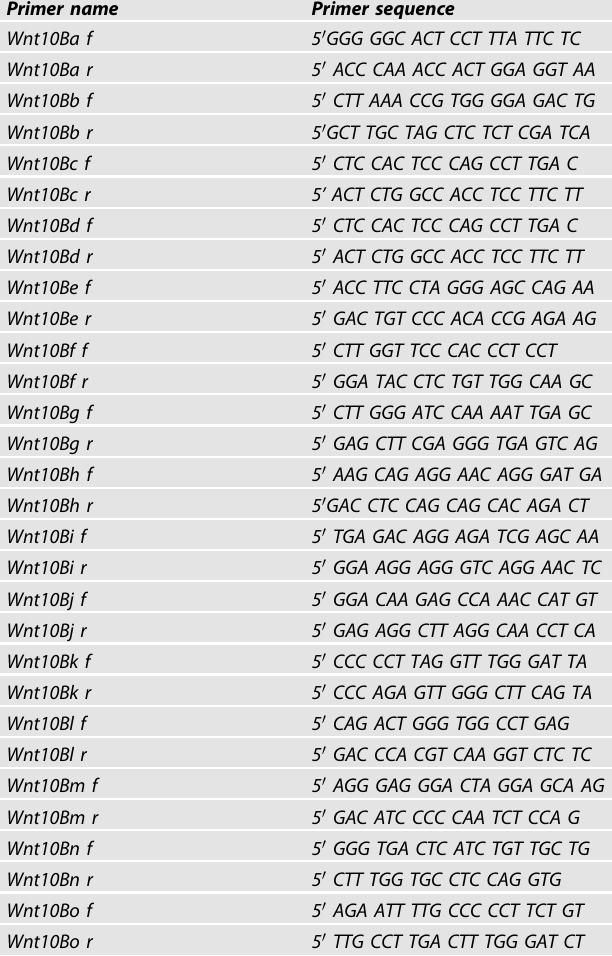
Table 1. Sequences of the primers used for the